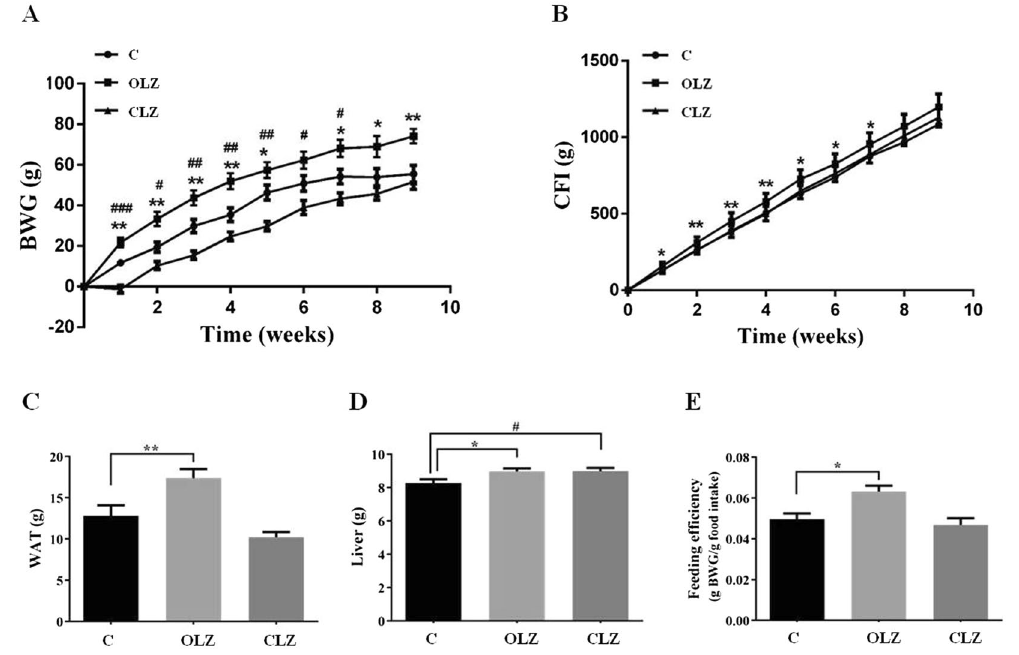
Figure 1. The effects of OLZ and CLZ treatment on ( A ) body mass, ( B ) food intake, ( C ) WAT, ( D ) liver and ( E ) feeding efficiency (gram weight gain/gram food intake). Rats were administrated orally with OLZ (3 mg/kg, b.i.d), CLZ (20 mg/kg, b.i.d) or vehicle for 9 weeks. Data are presented as mean ± SEM (n = 12 per group). * p < 0.05, ** p < 0.01 and *** p < 0.001: OLZ treatment vs. control, # p < 0.05, ## p < 0.01 and ### p <